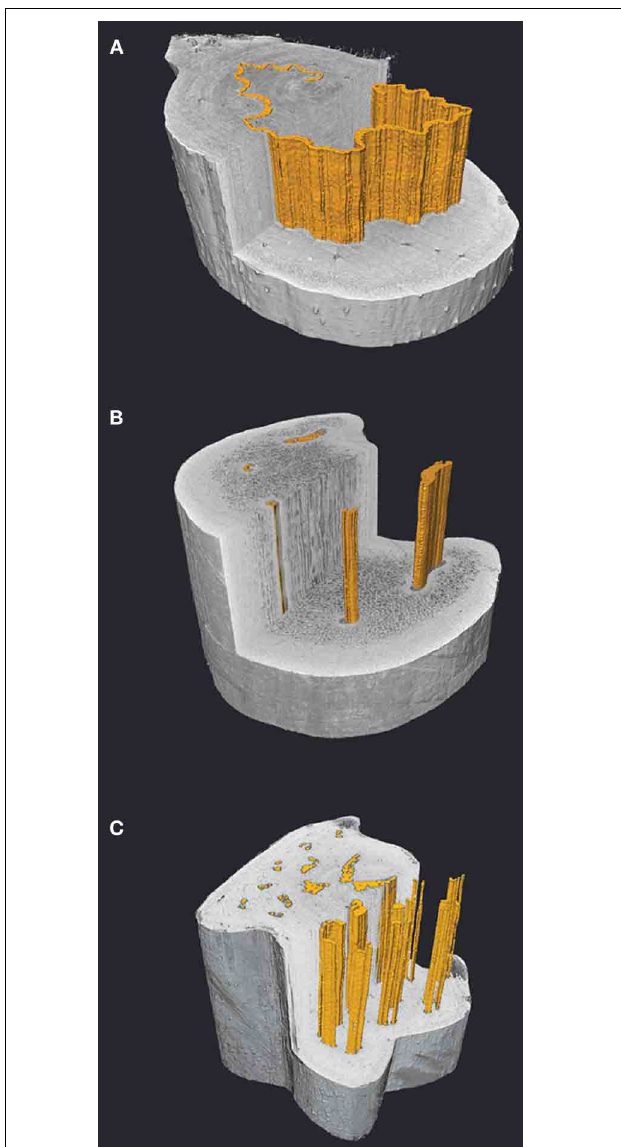
FIGURE 3 | Virtual transverse and longitudinal sections through frond stipes of Dicksonia antarctica (A), Woodwardia fimbriata (B) and Polystichum munitum (C) visualized with high resolution X-ray computed tomography (HRCT). The vascular bundles are highlighted in orange and show a small sample of the diversity of stelar patterns in ferns, with the continuous band of xylem in D. antarctica (A) , to the sectored xylem of W. fimbriata (B) . Despite the dissected appearance of the xylem in P. munitum (C) , 3D analysis reveals that the bundles make frequent connections resulting in a highly integrated network (Brodersen et al., 2011). The 3D organization and packing of tracheids along with the xylem associated parenchyma likely play a significant role in determining whether ferns are able to actively restore hydraulic function following xylem